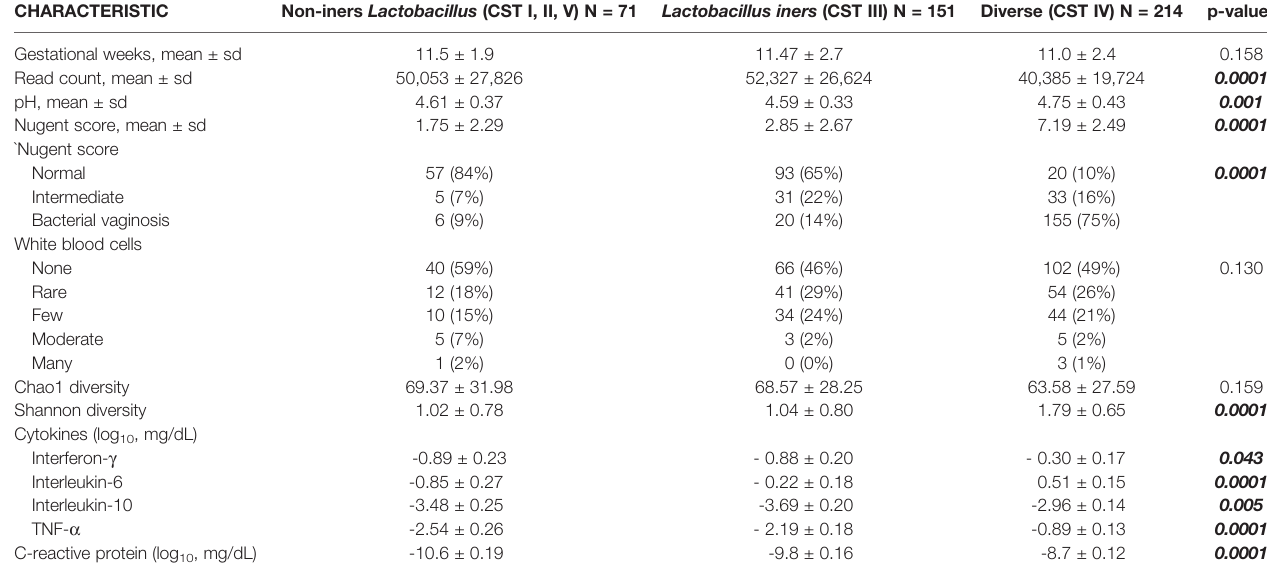
TABLE 2A | Early Pregnancy Vaginal Sample Characteristics According to CST Category.